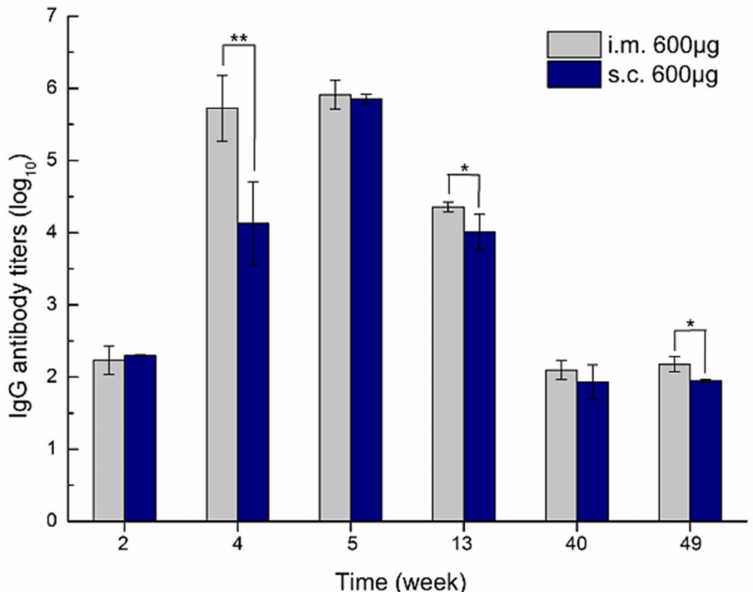
Figure 11. Zein-specific IgG titers in the sera of mice inoculated via intramuscular and subcutaneous routes with 600 µ g of 290 nm zein particles at weeks 0, 1, and 3, respectively. The sera of all six mice in each group were separately evaluated three times by ELISA. Results are expressed as means of antibody titers calculated from six mice per group. All p-value calculations are based on the t-test of the two-sample equal variance hypothesis. * p < 0.05, and ** p < 0.01. Reproduced with permission from [139], International Journal of Nanomedicine,